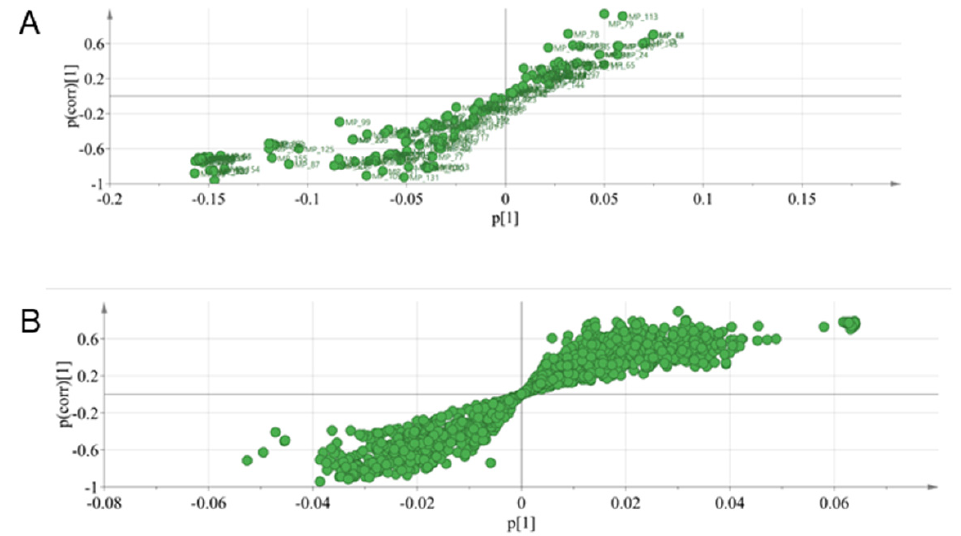
Figure 3. OPLS-DA analysis of OA group and control group: ( A ) in positive ion mode and ( B ) in negative ion mode.